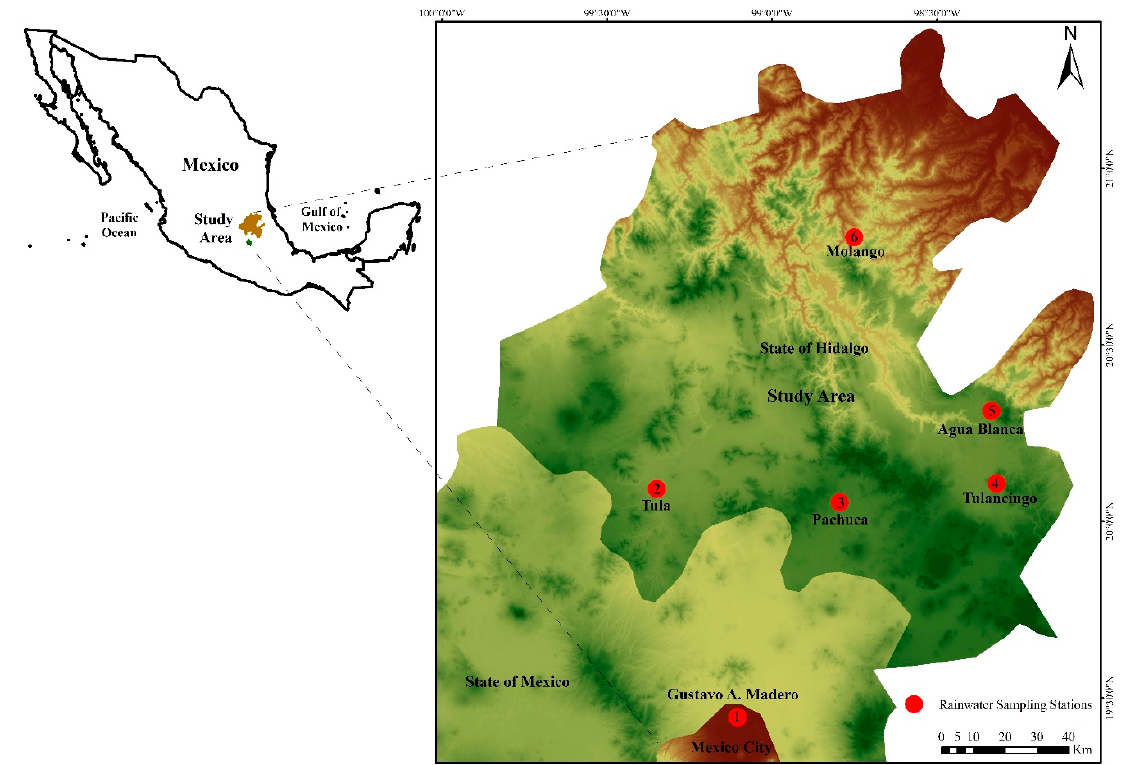
Figure 1. Study area map with the sampling locations in Central Mexico.